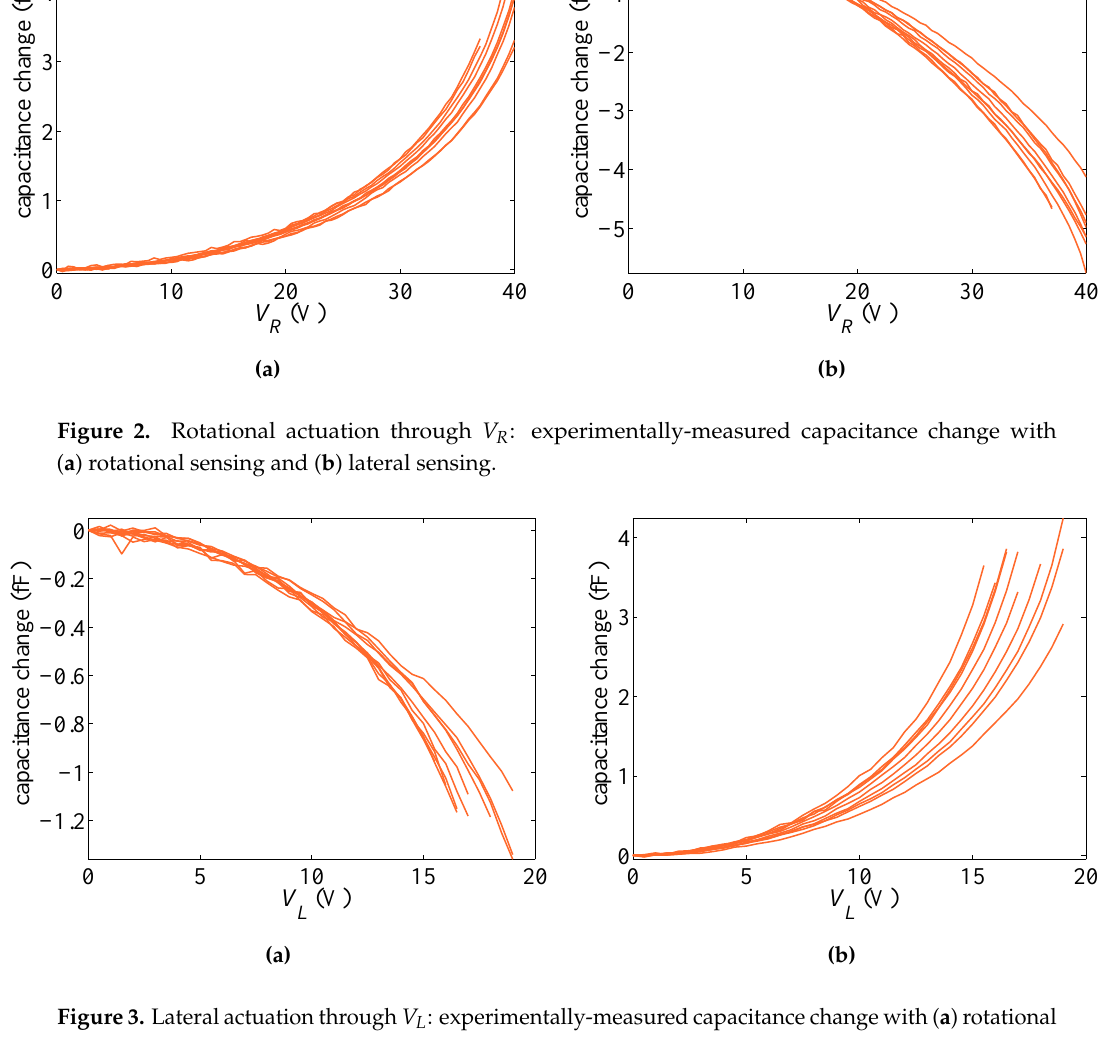
Figure 3. Lateral actuation through V L : experimentally-measured capacitance change with ( a ) rotational sensing and ( b ) lateral